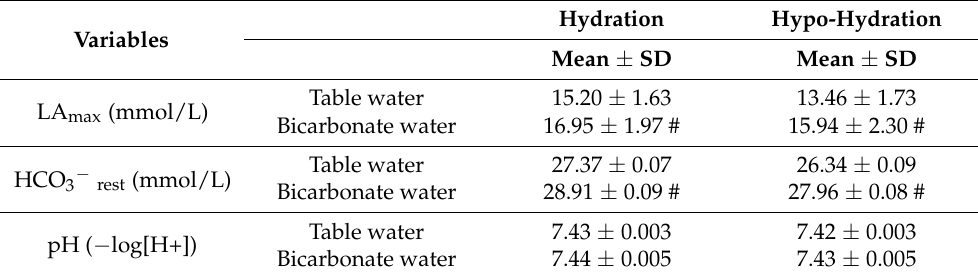
Table 4. The differences in post-exercise blood plasma lactate concentration, as well as the resting concentration of bicarbonate and blood pH values after table water and bicarbonate-rich water ingestion.